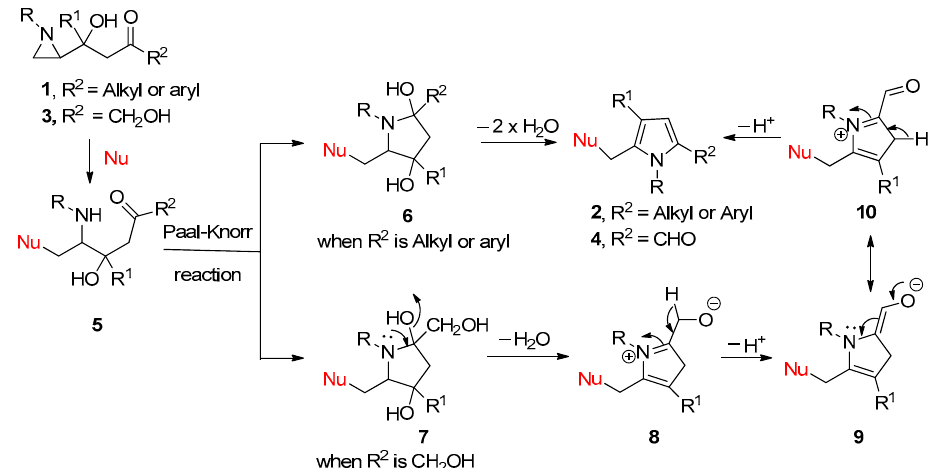
Scheme 5. Proposed reaction mechanism for the formation of 2 and 4 from 1 and 3 in two different